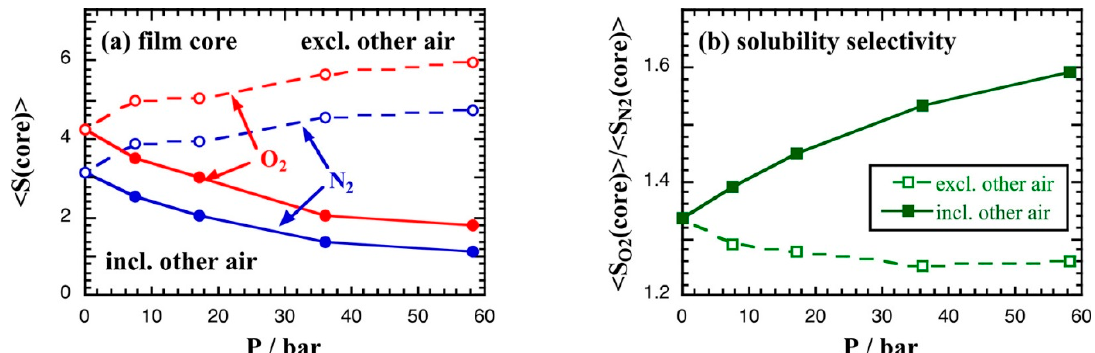
Figure9. ( a )Average(dimensionless)solubilityasafunctionofpressureforO 2 andN 2 ina6FDA-6FpDA polyimide glassy polymer film excluding (dashed lines) or including (solid lines) interactions with the other air molecules. ( b ) Solubility selectivity for O 2 / N 2 separation in the same film. Reprinted with permission from